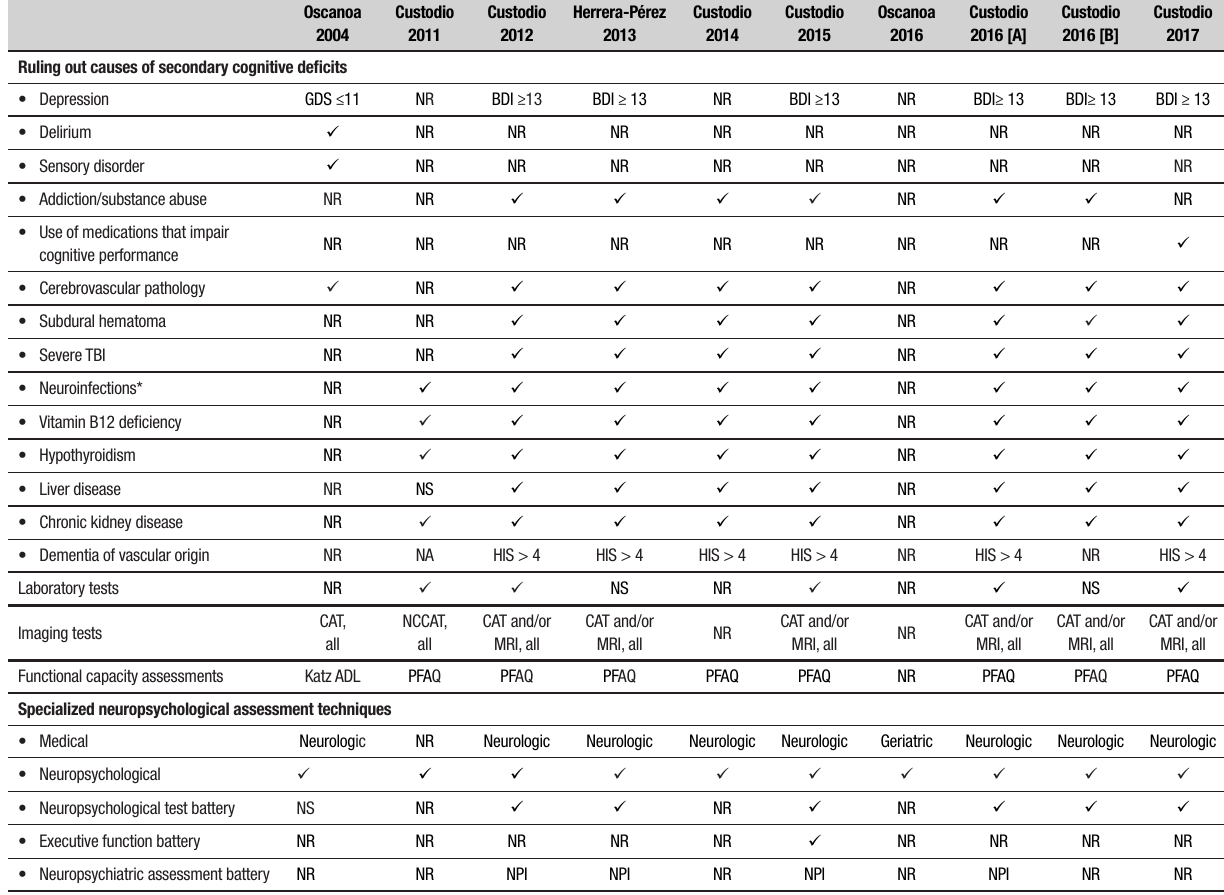
Table 3. Diagnostic protocol applied in studies